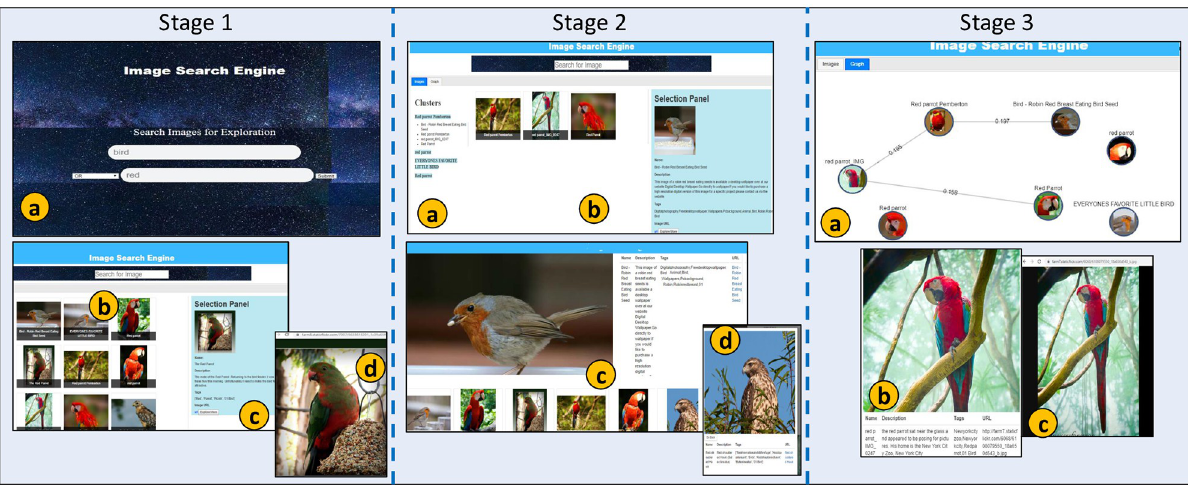
Fig 7. The grid exploration scenario (I) as a query is expressed in QFP ( a ), images results are presented in RGP ( b ), lookup of a selected image in SP ( c ), and access of an image from web source ( d ); The cluster-graph exploration scenario (II) as clusters hierarchy is presented in CLP ( a ), Cluster images presentation in RGP ( b ), lookup of a selected image in SP, exploration of an image in RRP ( c ) and lookup of a selected image in Information Window ( d ); The graph visualization exploration scenario (III) as images visualization in GVP ( a ), lookup of a selected image in Information Window ( b ), and access of an image from web source ( c ), against query ‘Bird’ AND ‘Red